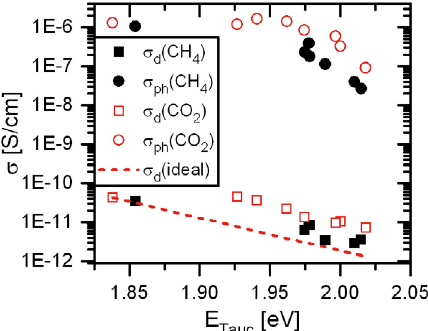
Fig. 9. Dark and photoconductivity of amorphous silicon alloy single layers produced with CO 2 or CH 4 against Tauc bandgap at room temperature.